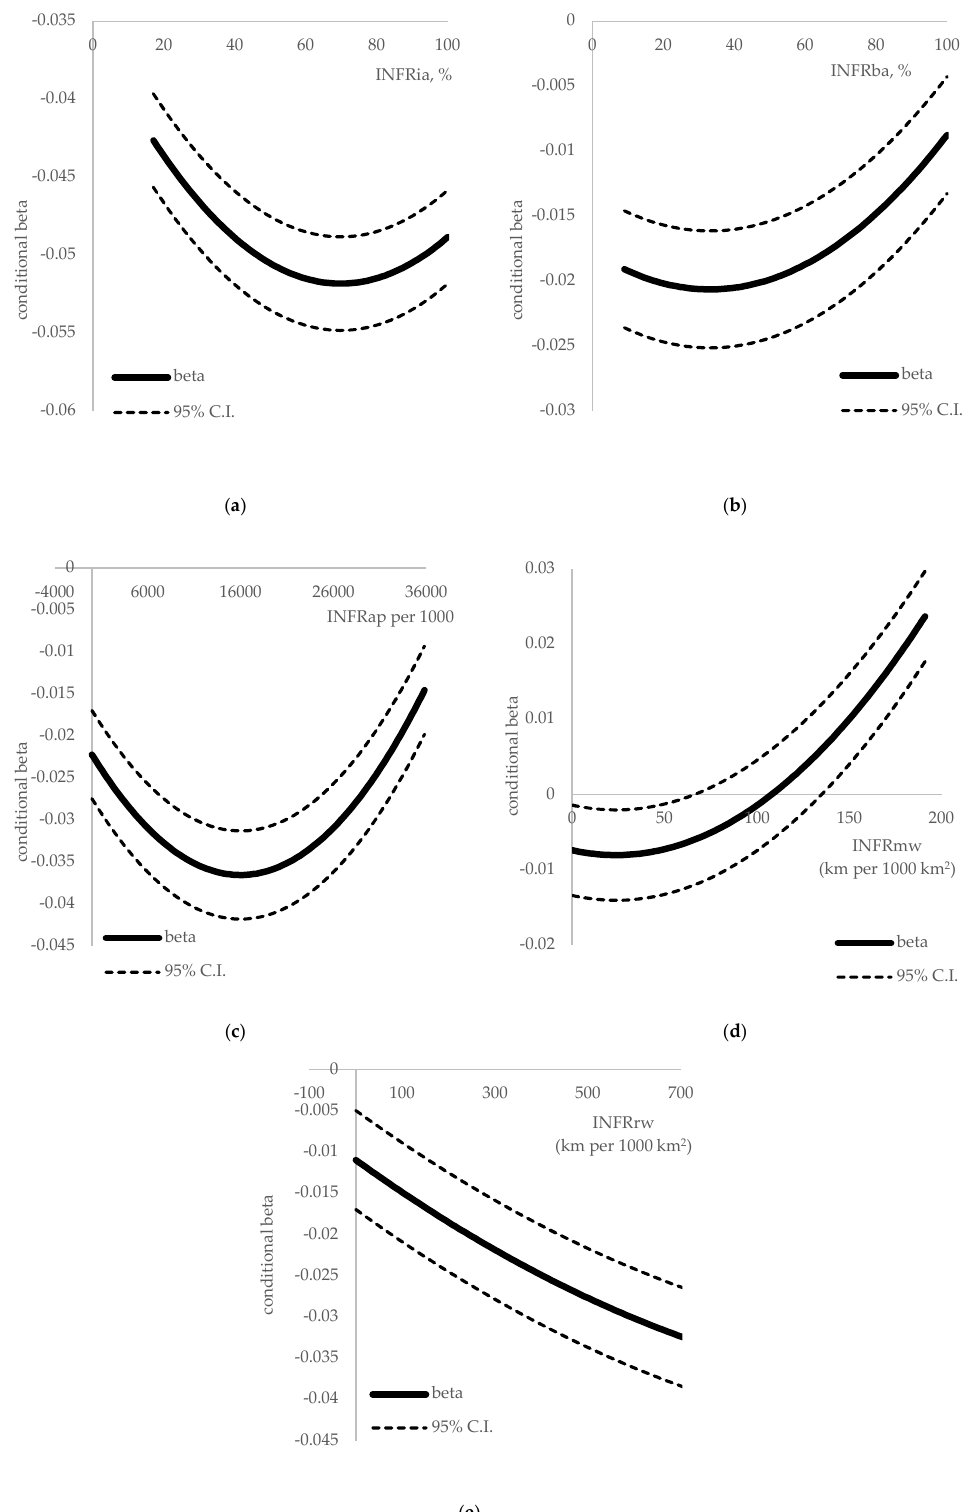
Figure 1. Relationship between different types of infrastructure development and speed of conver- gence, i.e., the conditional beta coefficient (calculated based on Equation (3)) and its 95% confidence interval (calculated based on Equation (4)). ( a ) Access to the internet; ( b ) Access to broadband inter- net; ( c ) Airport infrastructure; ( d ) Motorways infrastructure; ( e ) Railways infrastructure. Estimates show that the relationship between infrastructure development and re- gional convergence is non-linear and that extensive development of infrastructure in some regions, probably at the expense of others, can slow down the convergence. We estimate that convergence is fastest if internet access is at approximately 70%, broadband at 33%, air passengers per one thousand inhabitants is approximately 16,000, and the length of motorways per 1000 km 2 is 25. Above that level, convergence is still present but at a slower rate, except for the motorway infrastructure. Highly developed motorway infrastructure (the level above 110 km per 1000 km 2 ) in a few regions, with others lagging behind, could even trigger a divergence. Considering the railway infrastructure, its development is also nonlinearly linked to convergence with a diminishing marginal impact, but we do not see a tipping point over the range of the observed values. For the robustness check, we re-estimated Equation (2) using a 3-year forward-look- ing average growth rate as the dependent variable. Estimates are presented in Appendix A (Table A1). Additionally, using the same 5-year forward-looking average growth rate as the dependent variable, we re-estimated Equation (2) applying system GMM. Estimates are presented in Appendix A (Table A2). Results are consistent with our general estima- tions showing a non-linear relationship between infrastructure development and growth and a negative effect of infrastructure concentration on regional convergence. 4. Discussion and Policy Implications In our study of the impact of infrastructure development on convergence, we found some expected results, but some were surprising. As expected, the estimations revealed that conditional beta convergence between EU NUTS 2 regions is present. It is in line with Bisciari, Essers & Vincent [31], Butkus, Mačiulytė-Šniukienė & Matuzevičiūtė [32], Car- tone, Postiglione, & Hewings [33] findings. However, regional economic disparities are still substantial [11], and the rate of convergence is slow. Therefore, policymakers need to make decisions that would promote convergence. Our analysis shows that economic growth is positively related to capital investment, investment in R&D, human capital, the quality of governance, and agglomeration. Therefore, to encourage convergence, it is ex- pedient to increase capital investment, support the creation and spread of innovation, im- plement human capital development programs, and ensure government quality in